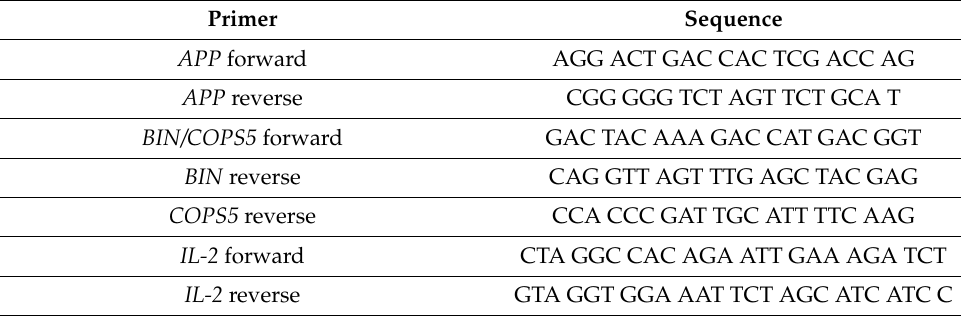
Table 2. IL-2 primers were used as controls for DNA extraction and amplification. Table 1. List of primers used for